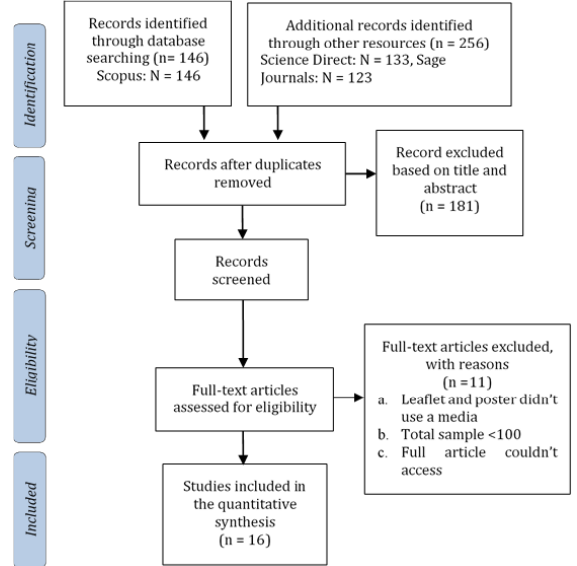
Figure 1. PRISMA study flow